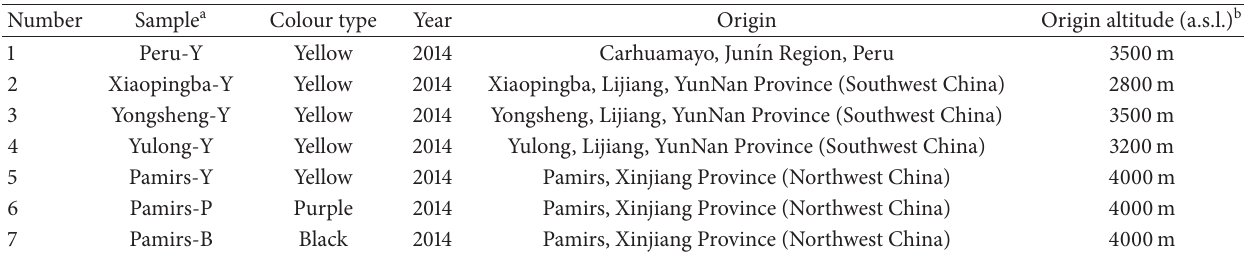
Table 1: The information of 7 maca